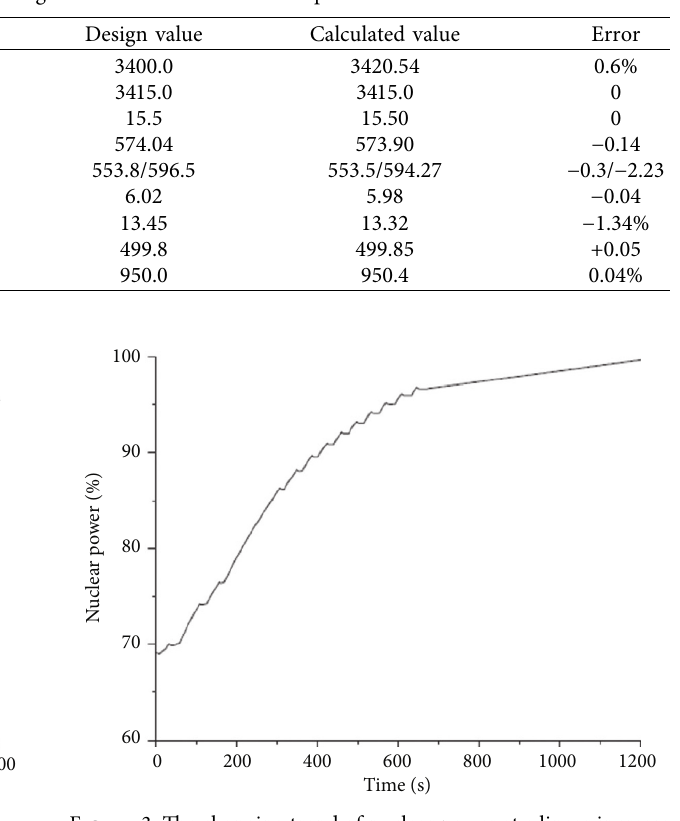
Figure 2: The changing trend of the turbine flow at a linear increase in the load.